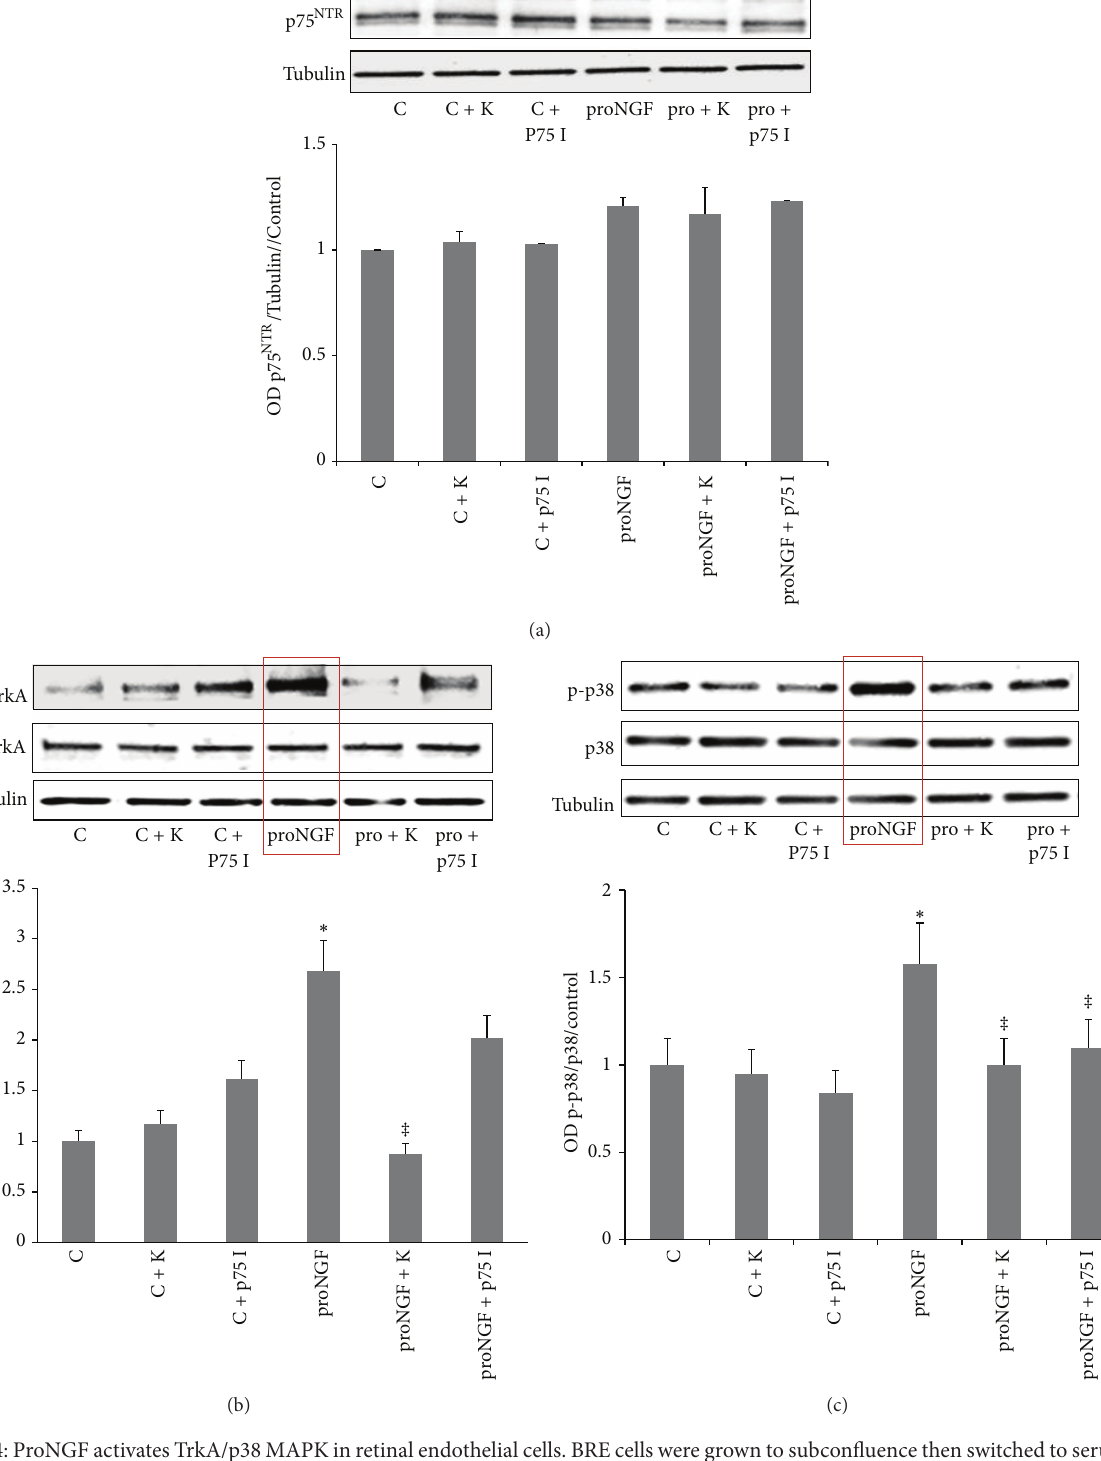
Figure 4: ProNGF activates TrkA/p38 MAPK in retinal endothelial cells. BRE cells were grown to subconfluence then switched to serum free medium and treated with mutant proNGF (50ng/mL). Cells were harvested after 4 hours and subjected to western blot. (a) Representative image of p 75 NTR and tubulin showing no significant change in p 75 NTR expression among various groups. (b) Representative image and statistical analysis showed that proNGF is capable of activating TrkA in BRE cells compared to control cells. Treatment of BRE cells with the TrkA antagonist K252a abolished the ability of proNGF to activate TrkA while pharmacological inhibition of p 75 NTR modestly increased TrkA activation. (c) Representative image and statistical analysis showed that proNGF activates p38 MAPK compared to controls. Inhibiting TrkA or p 75 NTR abolished the ability of proNGF to activate p38 MAPK ( ∗,‡ statistically significant compared to control and proNGF groups, resp., ( 𝑃 < 0.05 ), 𝑛 = 3 – 5